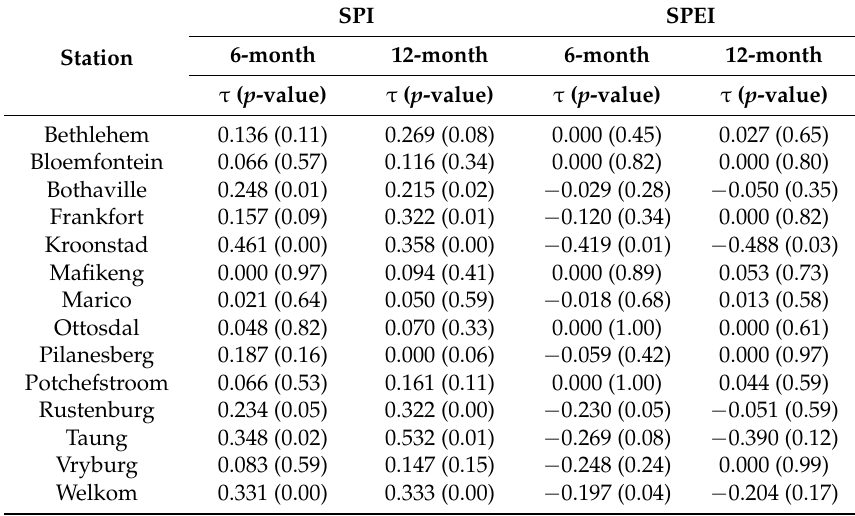
Table 7. Trends in drought frequency of SPI/SPEI-6/12 across the selected weather stations.